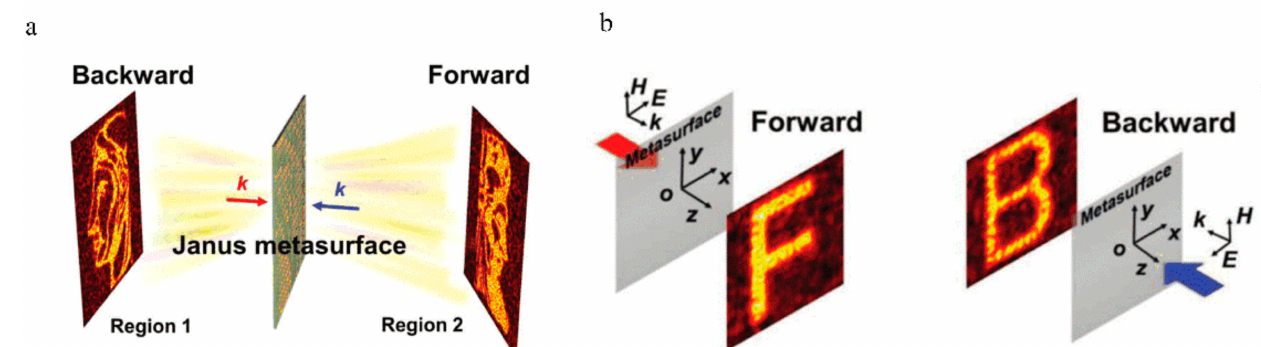
Figure 7. ( a ) Illustration of a Janus metasurface with bidirectional transmission for full-space wave manipulation. Adapted with permission from ref. [119]. Copyright 2019 John Wiley and Sons. ( b ) The incident wave forms different holograms for the two different propagation directions. Adapted with permission from ref. [119]. Copyright 2019 John Wiley and